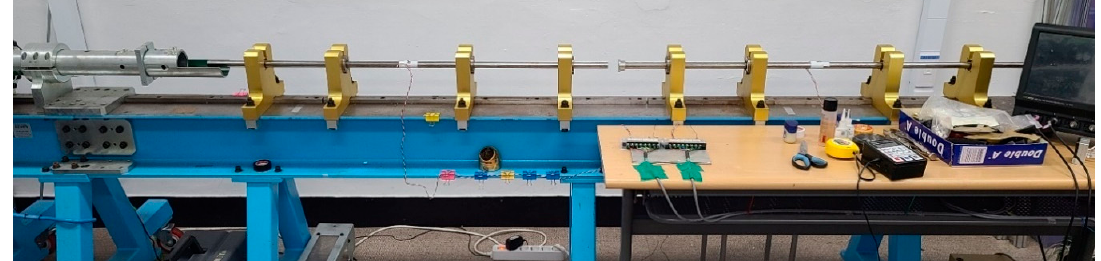
Figure 2. SHPB used in this study, owned by the Department of Aerospace Engineering at Pusan National University [25]. To satisfy the 1D wave equation, the SHPB put the pressure bars and the specimen in a straight line, and the ratio of the length ( L B ) and diameter ( D B ) of the bar is more than 20 [19]. Table 1 shows the pressure bar length of the equipment used in this study. Table 1. Dimensions of the SHPB pressure